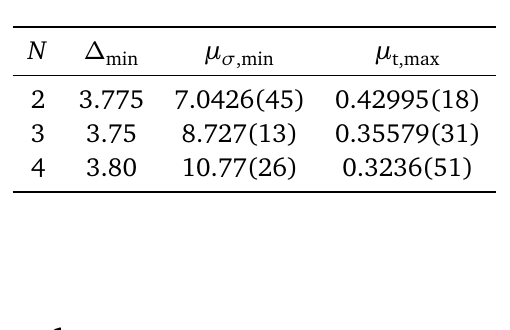
Table 5: Additional bounds from the positive